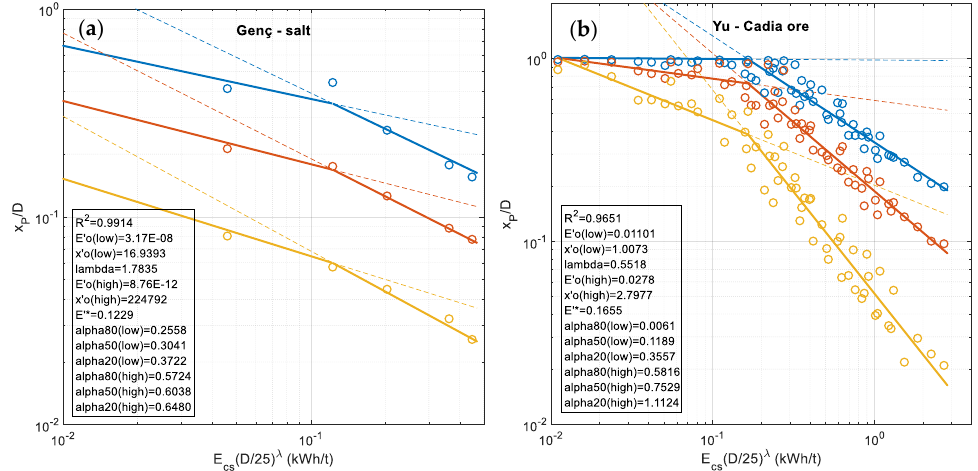
Figure A5. Double fan for Genç ’s [ 25] salt ore ( a ) and Yu’s [ 26] Cadia ore ( b ). Solid lines are the actual high- and low-energy percentile lines, dashed lines are extrapolations out of their ranges of validity. Circles are data. Percentiles colors: blue — 80 %, red — 50 %, yellow — 20 %.